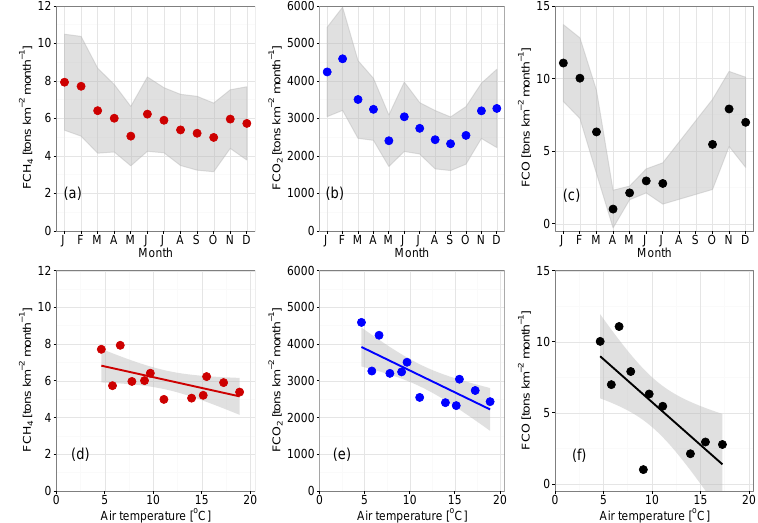
Figure 7. (a–c) Monthly averages of F CH4 , F CO2 and F CO (September 2011–December 2014); (d–f) F CH4 , F CO2 and F CO as a function of monthly mean air temperature. Solid lines are linear regressions and shaded areas are 95% confidence intervals. No F CO measurements were available in August and September due to instrument